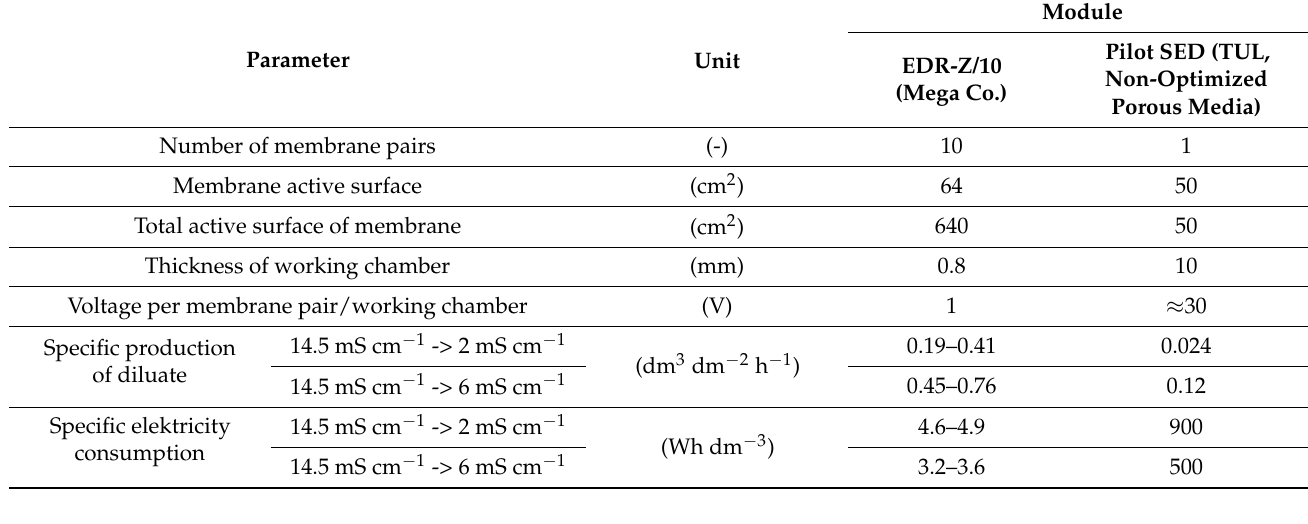
Table 7. Comparison of operating parameters of standard vs. shock electrodialysis reversal (standard lab unit EDR-Z/10 by Mega co. and pilot shock ED unit by Technical University of Liberec, generation IV module—without optimization of charge of porous media) [40].